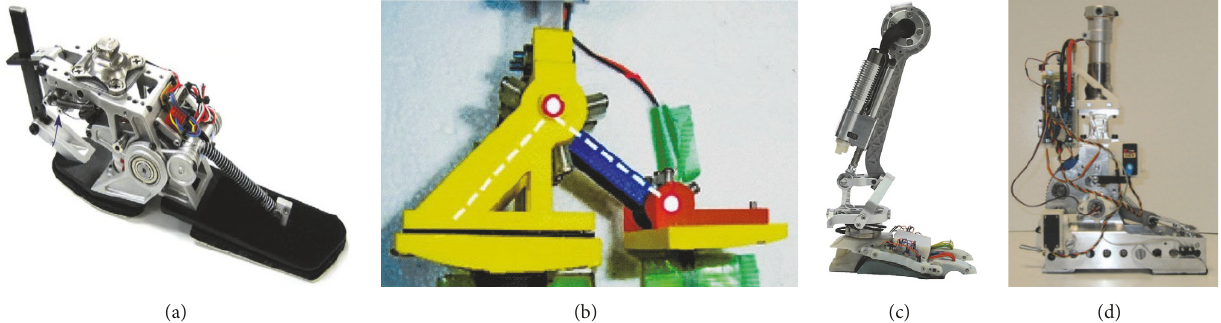
Figure 11: Developed foot prostheses. (a) Energy recycling foot [21, 22]. (b) Adaptive bipedal deformable feet [23]. (c) An adaptive sensor foot for a bipedal and quadruped robot [24]. (d) The AMP-Foot 1.0